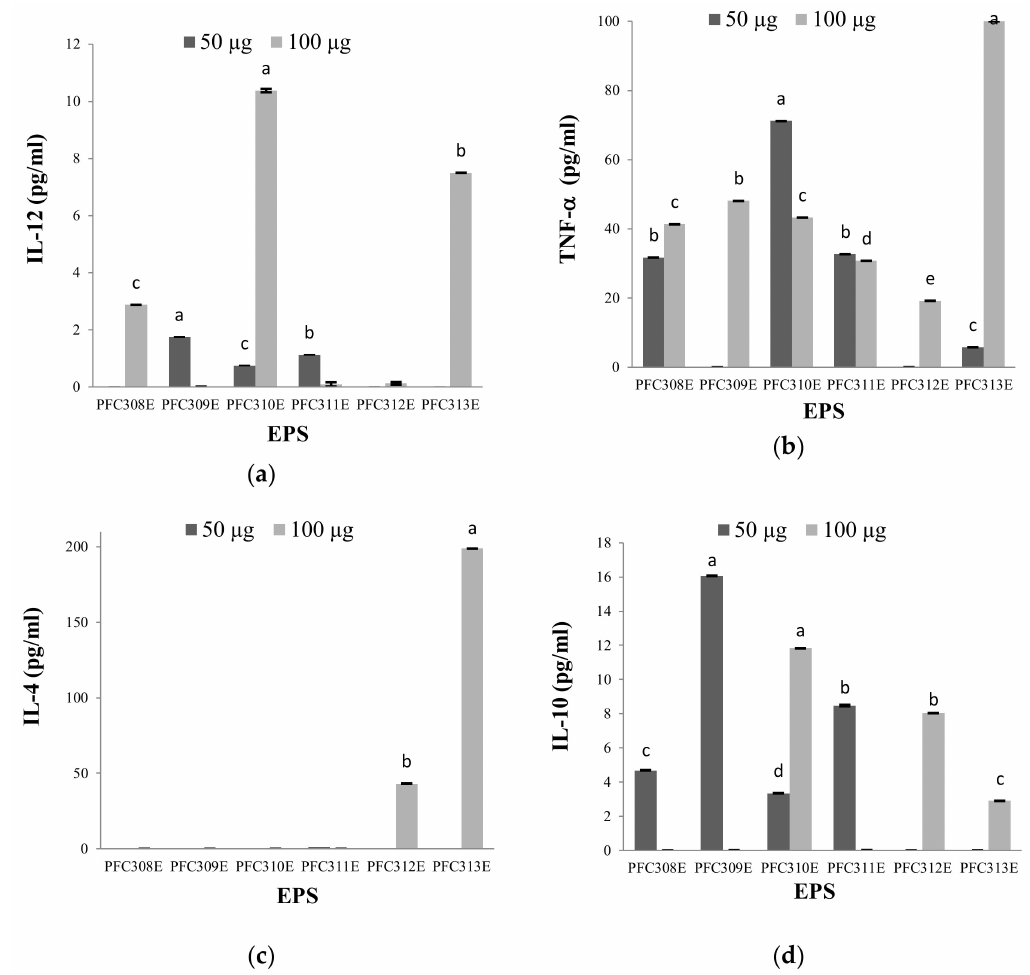
Figure 1. The cytokine response concentrations (pg / mL) at HT-29 cell lines stimulated by ropy EPS produced from L. plantarum strains. Cytokines ( a ) IL-12, ( b ) TNF- α , ( c ) IL-4 and ( d ) IL-10. Di ff erent letters show di ff erences ( p < 0.05) between the EPS at each cytokine